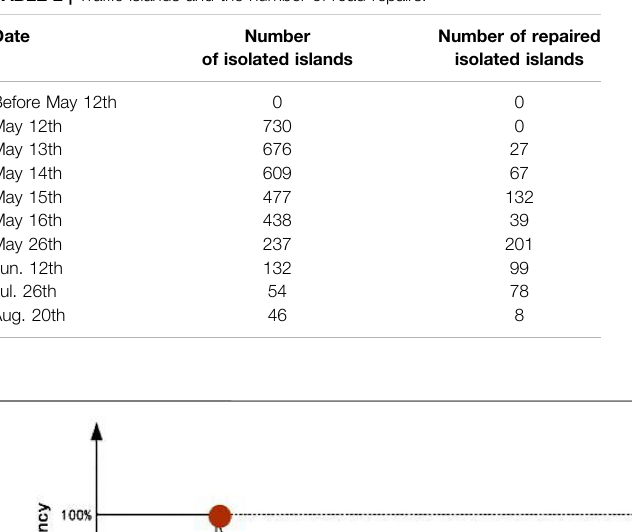
TABLE 2 | Traf fi c islands and the number of road repairs.